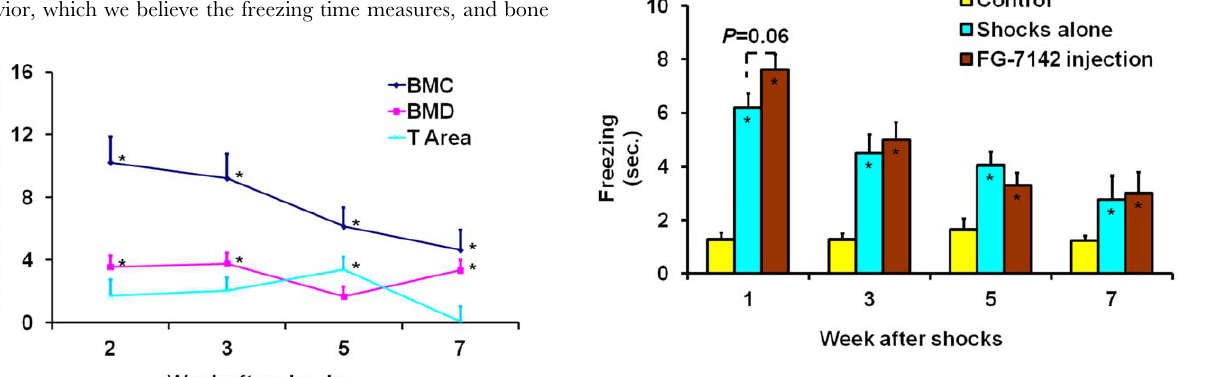
Figure 3. Effect of electric shocks alone and electric shocks plus FG-7142 injection on freezing behavior. Values are means and S.E.M. of freezing duration (sec) during 10-sec test periods. The significance of each treatment compared to the control at each time point is indicated by an asterisk for P , 0.05 inside the corresponding bar. The significance between two treatments is indicated by the actual P value above the corresponding bars.